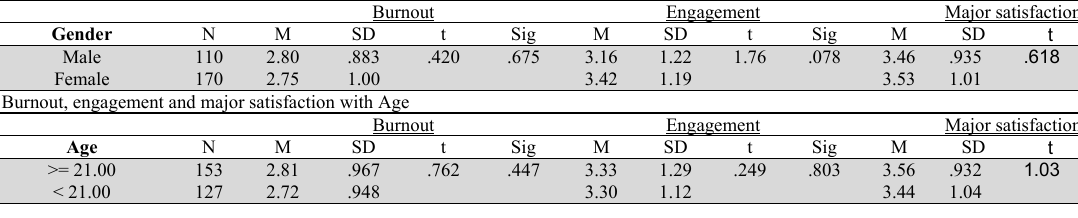
Burnout, engagement and major satisfaction with